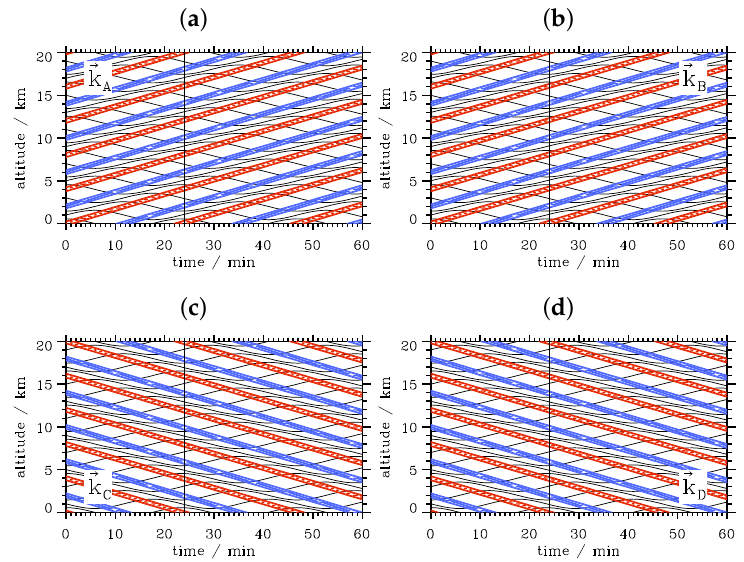
Figure 4. Vertical time series of the vertical displacements ξ ( x , z , t ) of horizontally- and vertically-propagating plane waves for the four wavenumber vectors (cid:126) k A ( a ), (cid:126) k B ( b ), (cid:126) k C ( c ) and (cid:126) k D ( d ) recorded at the positions marked in Figure 3. The values of the horizontal and vertical wavenumber components are k = ± 2 π / λ x with λ x = 8km and m = ± 2 π / λ z with λ z = 4km, respectively. Red and blue contour lines refer to ± 0.95 times the wave amplitude and illustrate phase lines. The vertical black lines refer to the time when the plots shown in Figure 3 are